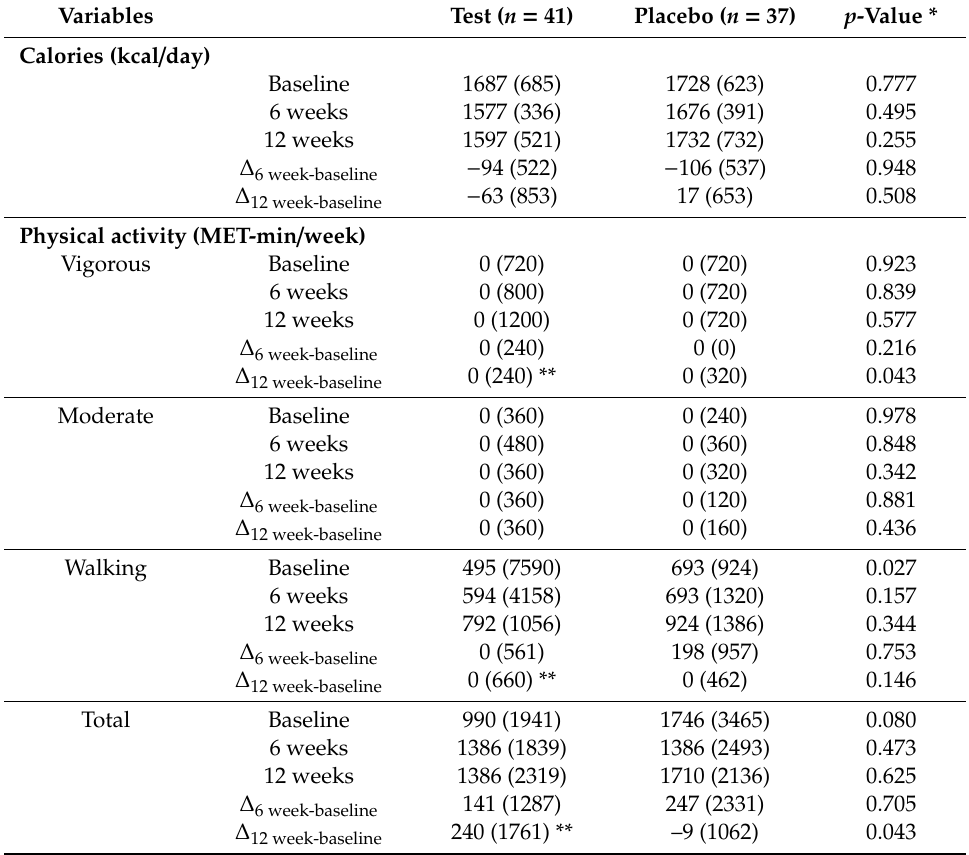
Table 2. Energy intake and physical